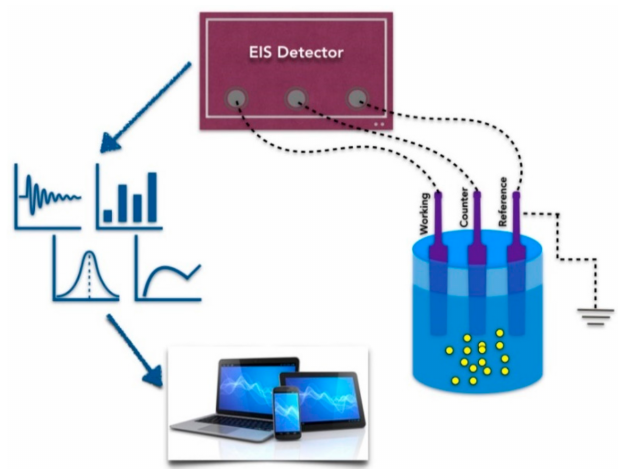
Figure 2. Schematic view of a biosensor. EIS, Electrochemical Impedance Spectroscopy.